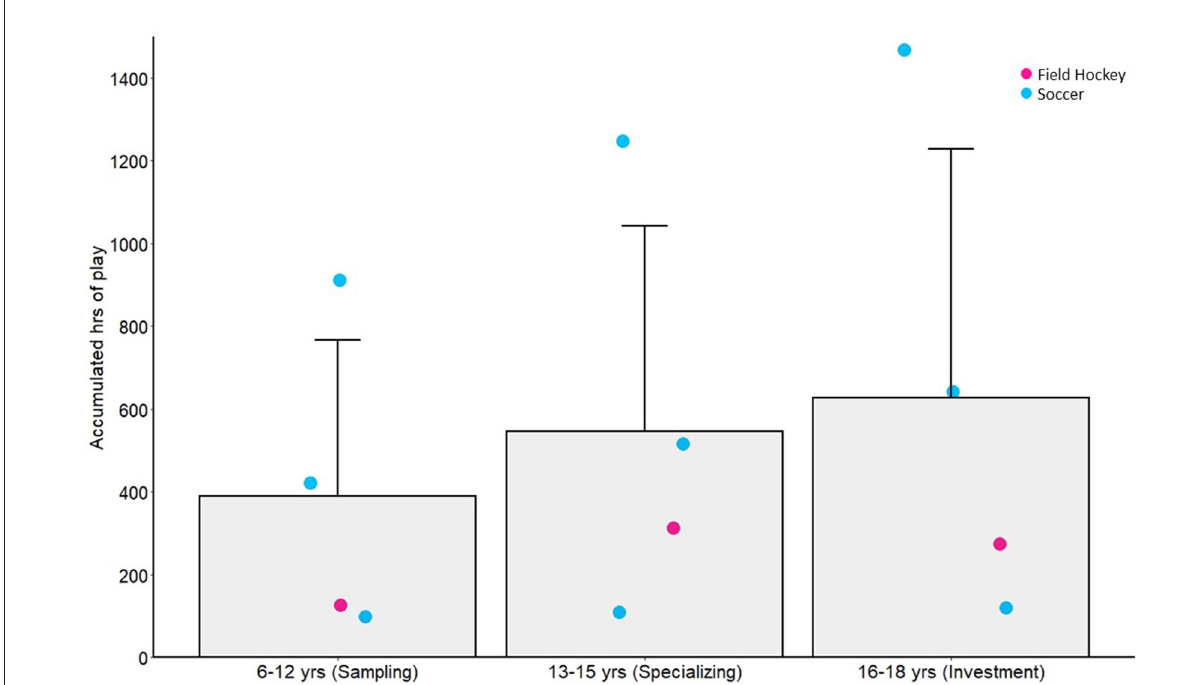
FIGURE6 Sample (bar) and individual study means (colored circles) across different age categories defined in past literature as the sampling, specializing and investment years, for average accumulated hours of play. Error bars represent sample standard deviation and colored circles represent individual sport groups. The “Specializing and Investment” category represents data that span the ages in those